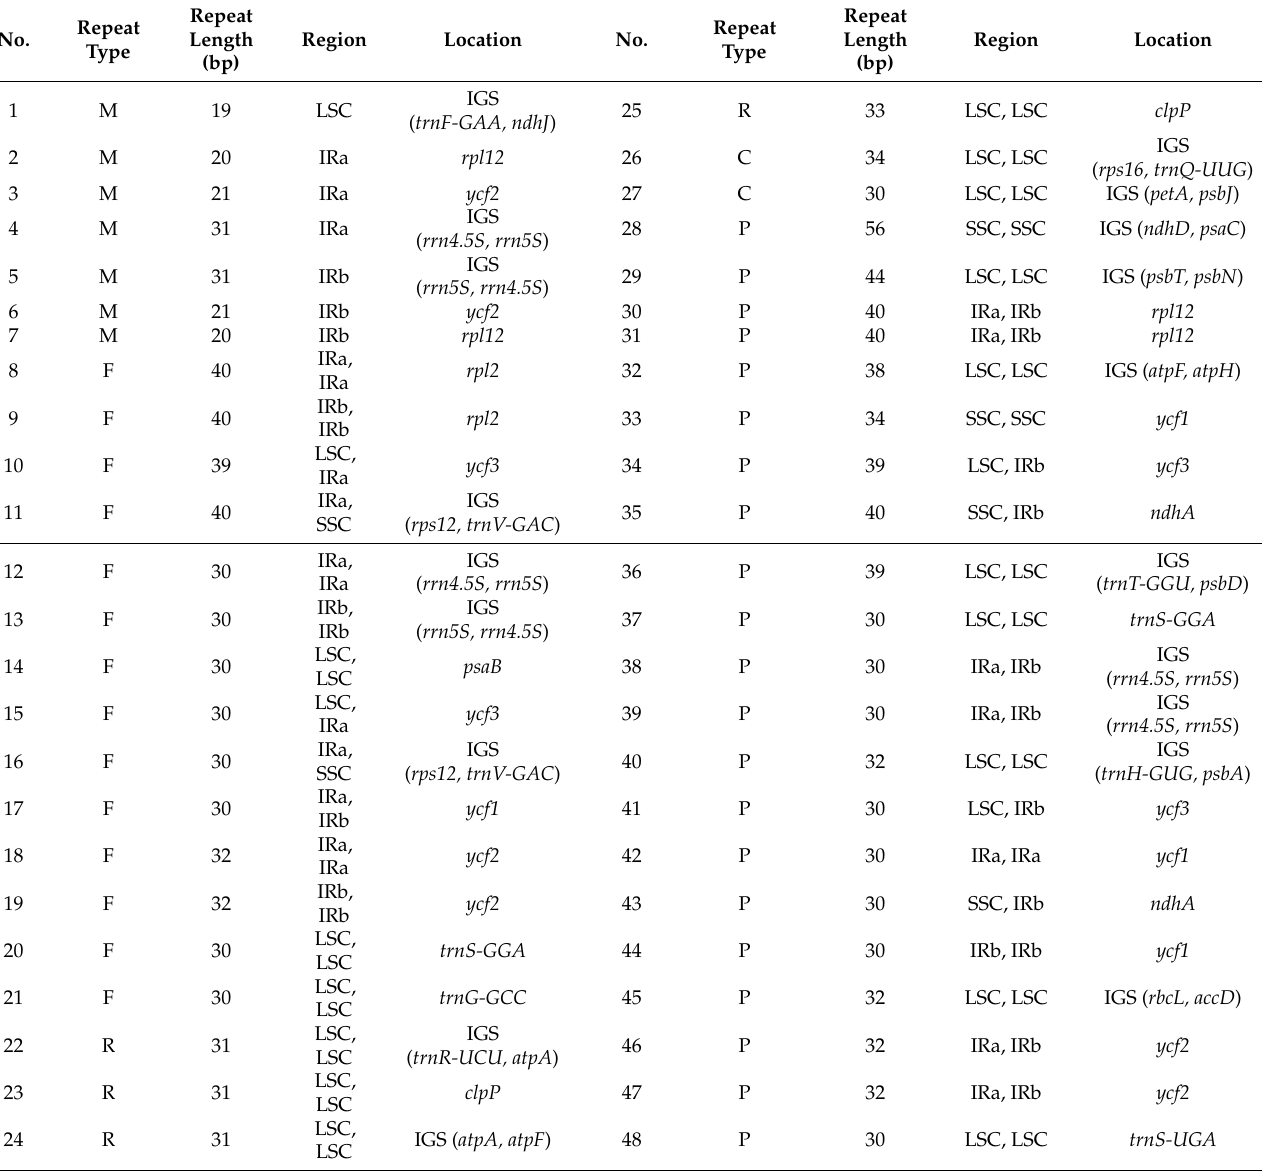
Table 4. The long repeat sequences, including minisatellite sequences (M), forward repeat sequences (F), reverse repeat sequences (R), complementary repeat sequences (C), and palindromic repeat sequences (P), in the cp genome of Q. litseoides